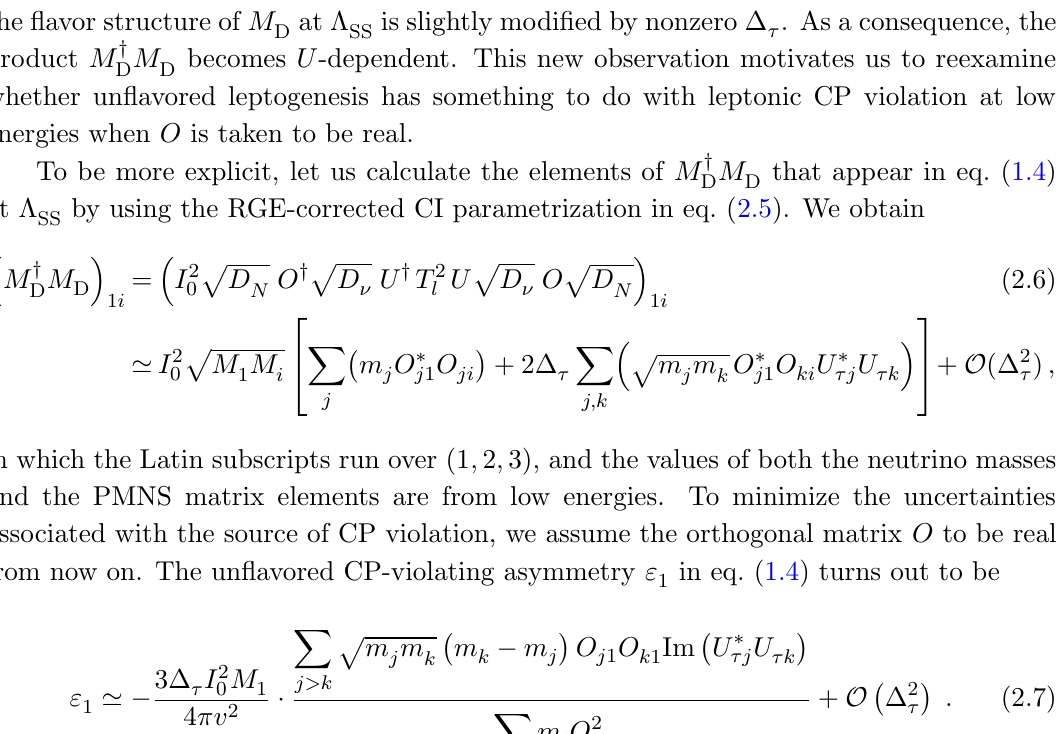
2 [10 12 ; 10 14 ] GeV in the SM. SS . As a consequence, (cid:28)